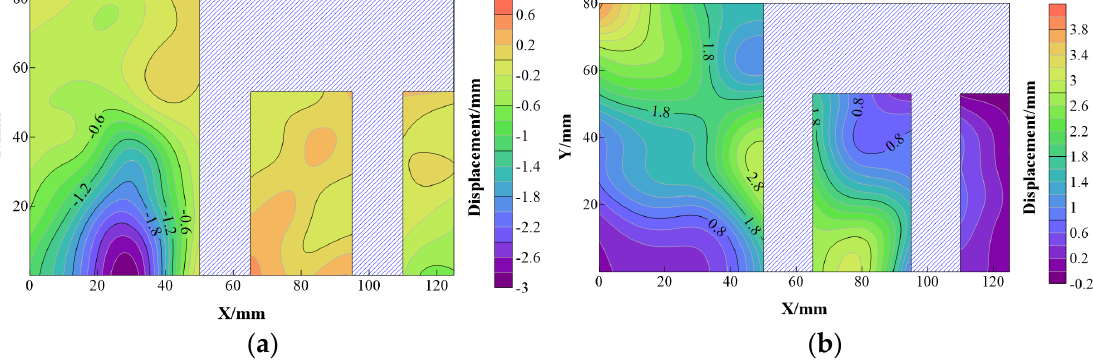
Figure 11. Vector diagram of soil displacement for MN-15 model.